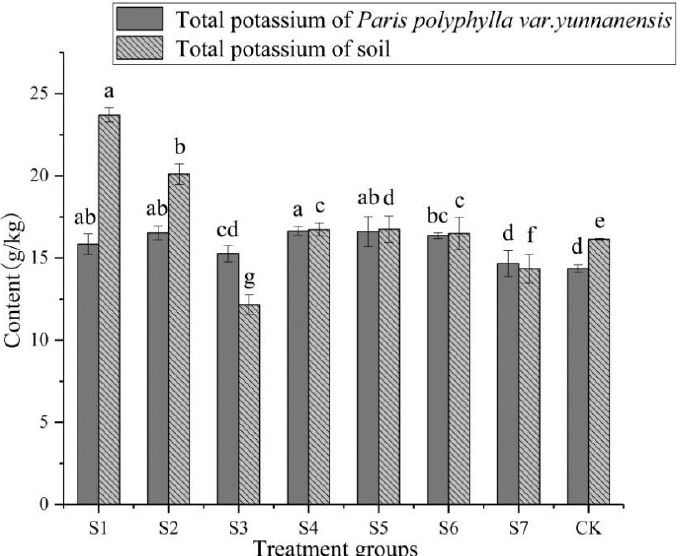
Figure 4. Effects of potassium-solubilizing bacteria on potassium absorption in rhizosphere soil of Paris polyphylla var. yunnanensis. a – g: Different letters indicate significant difference between each other ( p < 0.05)